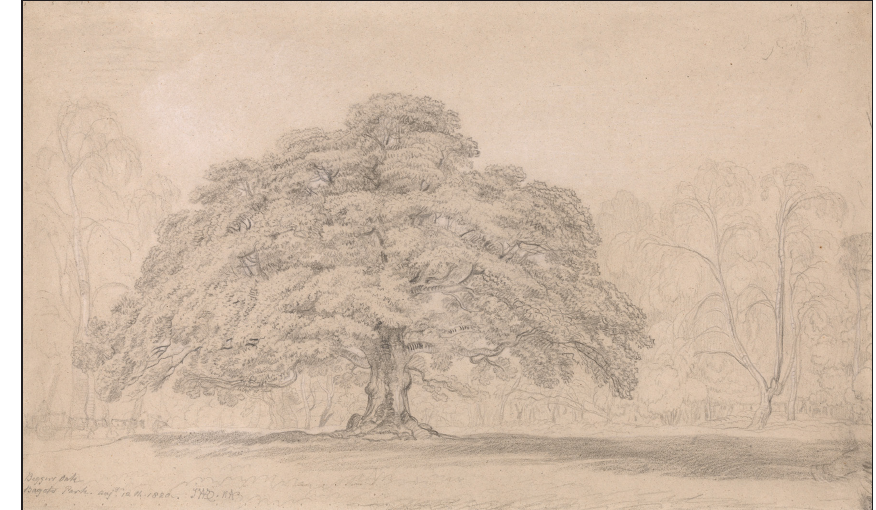
Fig . 4 : James Ward, The Beggar’s Oak, Bagot’s Park, Aug. 12th, 1820 (A Celebrated Ancient Tree on Lord Bagot’s Blithfield Hall Estate in Staffordshire) , 1820, graphite on paper, 34.6 × 57.8 cm, Yale Center for British Art, Paul Mellon